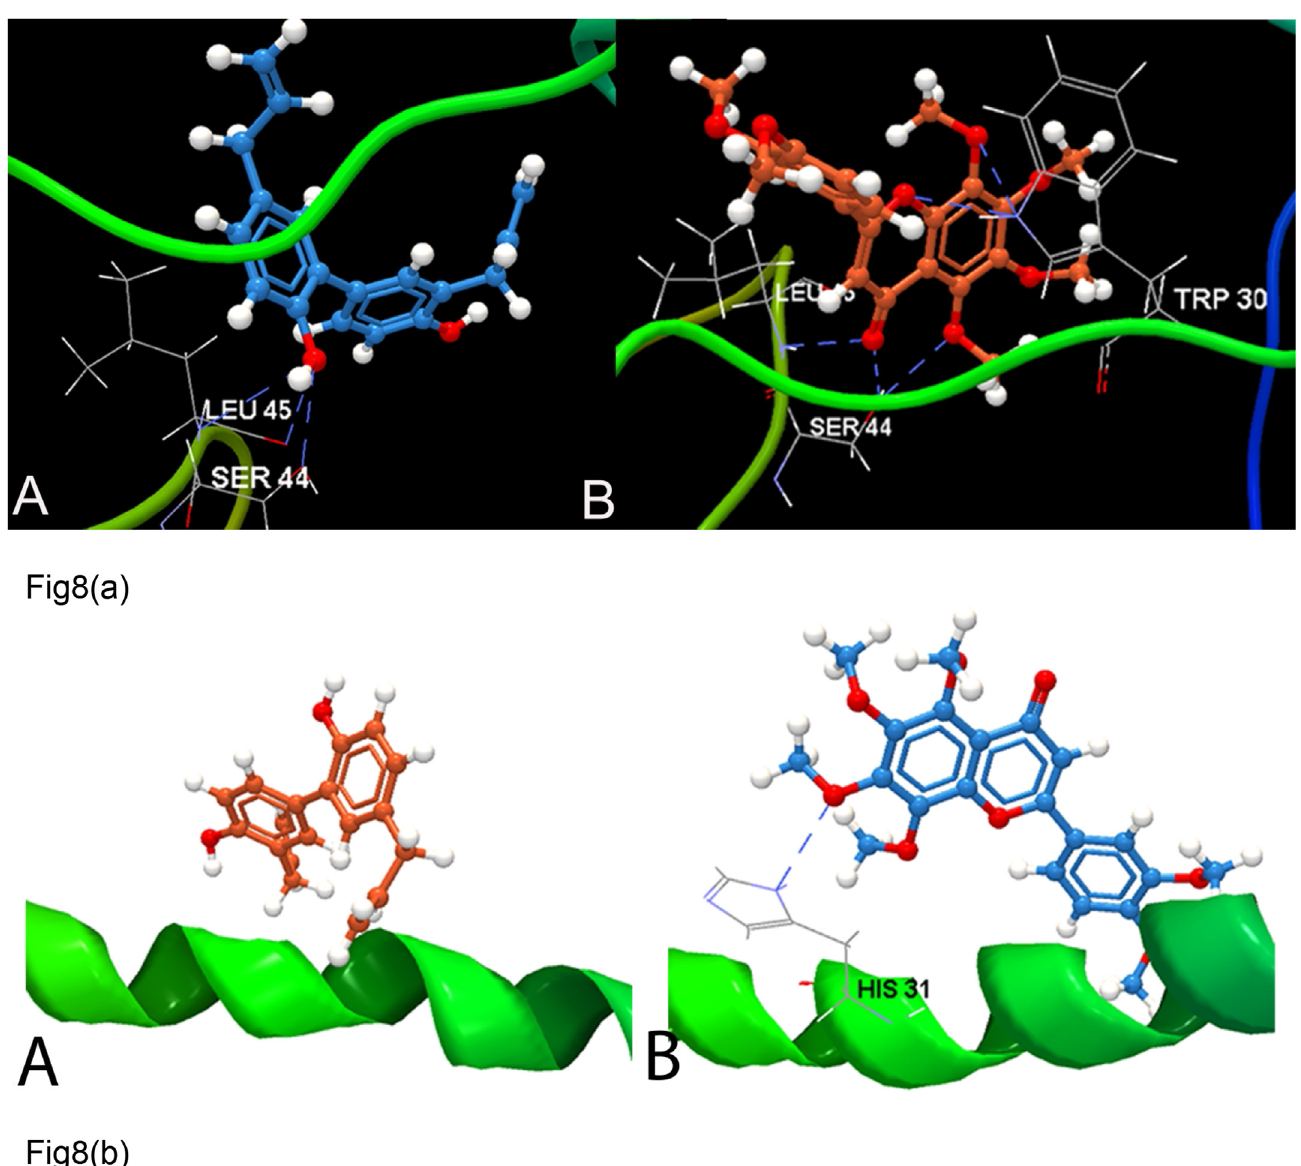
Fig 8. Analyzing docking interaction of p7 model between GT3 and GT4 with phenol compounds. (A) Molecular interaction of GT3 p7 model with phenolic compounds (a) Honokiol and its methoxy derivative (b) Nobiletin. Hydrogen bonds have been shown as blue dashed lines. (B) Interaction of GT4 p7 model (shown as green ribbon) with phenolic compounds (a) Honokiol (b) Nobiletin. Hydrogen bonds have been shown as blue dashed